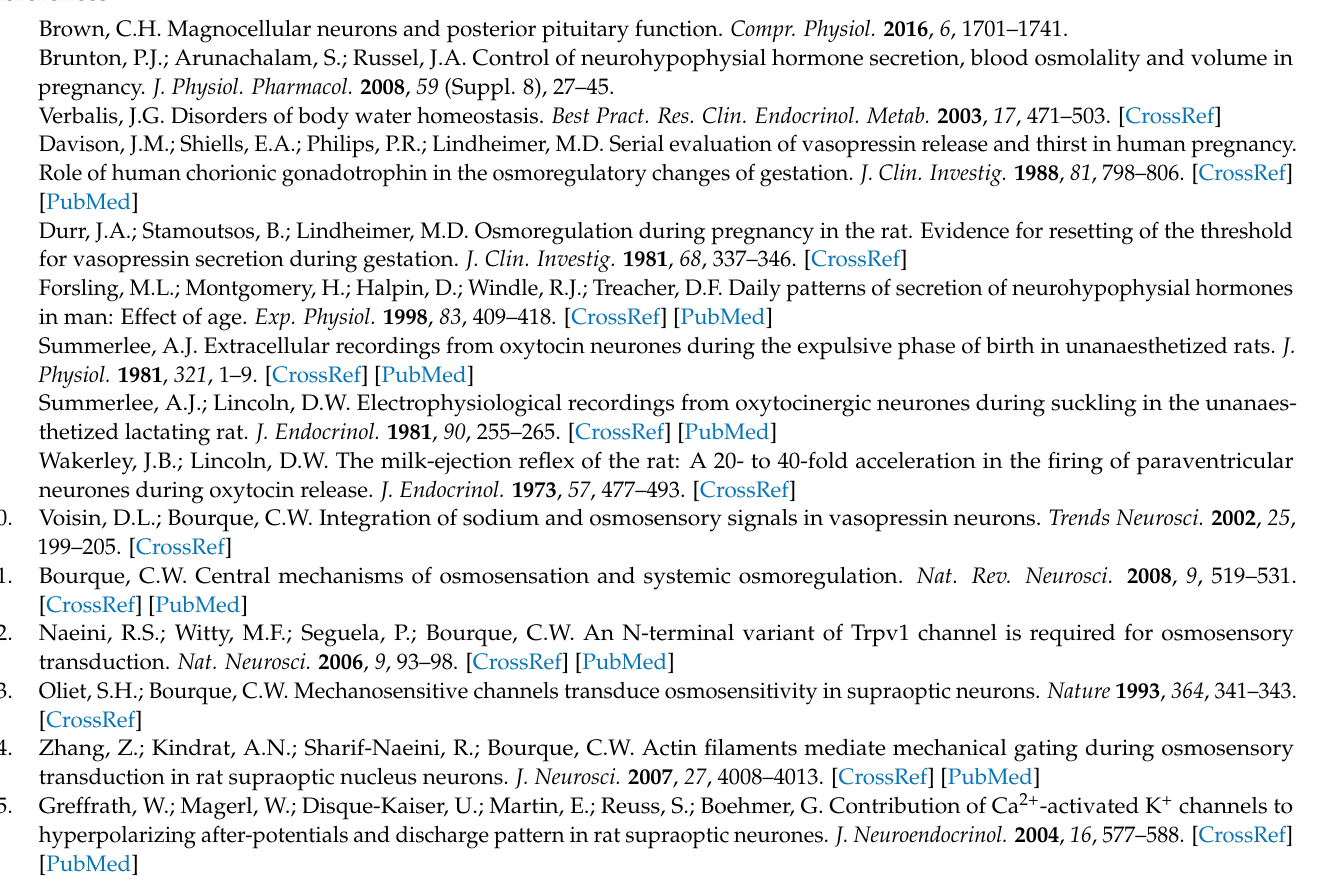
reproduction. Figure S3. (A–C) Coefficient of variation of oxytocin neurons, vasopressin neurons and phasic vasopressin